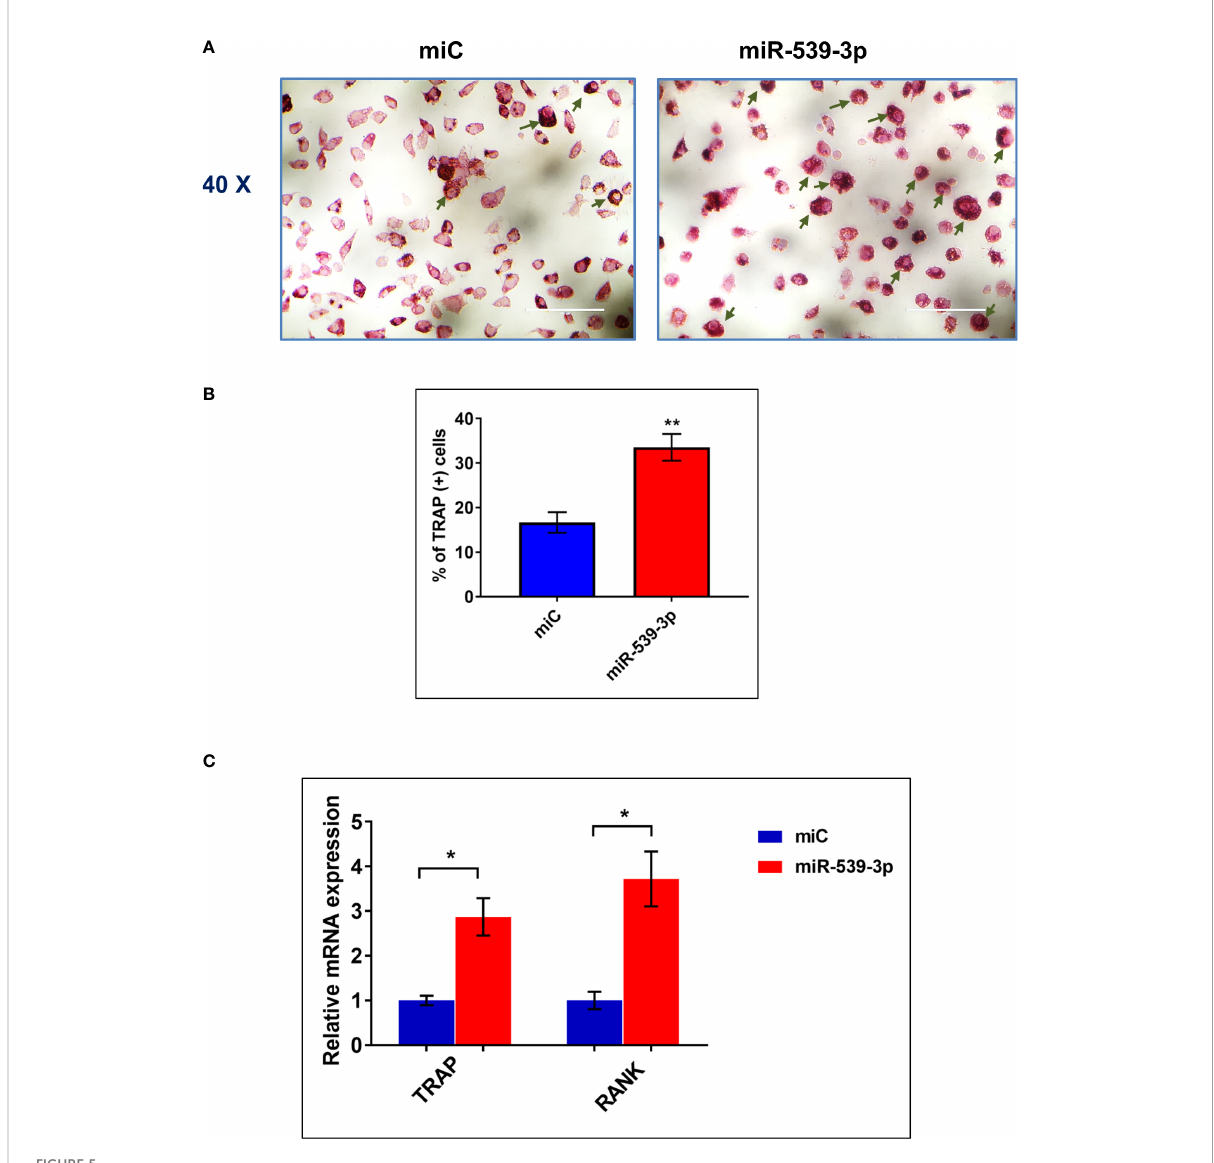
FIGURE 5 miR-539-3p induced osteoclasts differentiation (A) Representative photomicrograph (40x magni fi cation) shows induction of osteoclastogenesis by miR-539-3p from BMCs in presence of M-CSF (30 ng/ml) and RANKL (50 ng/ml) in six days culture. (B) Quantitative analysis of TRAP + cells from ten different areas at various treatment conditions. (C) Quanti fi cation of mRNA levels of TRAP and RANK gene, by qPCR analysis from the total RNA isolated from cultured cells. Data represents three independent experiments and expressed as mean ± SEM followed by the unpaired t-test of signi fi cance *p < 0.05, **p < 0.01 using Prism version 7.04